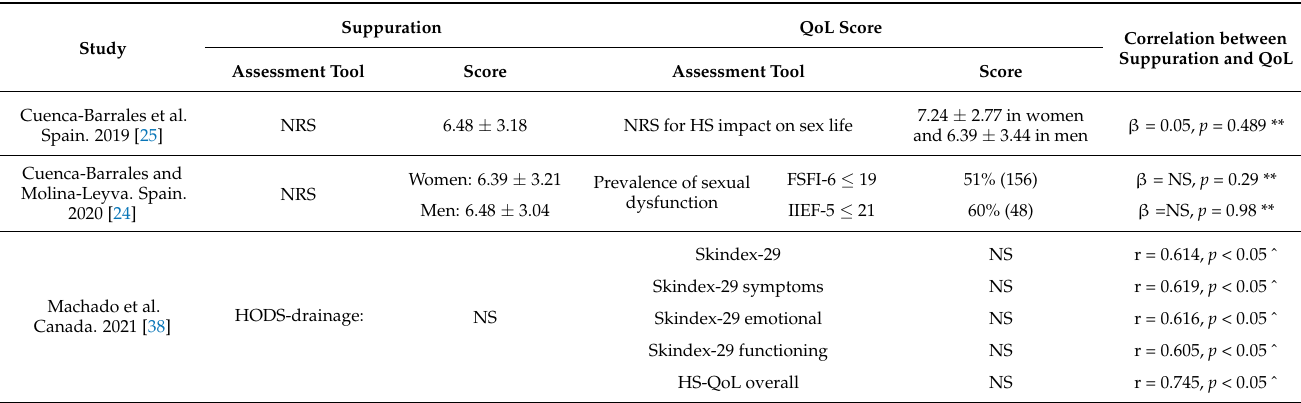
Table 5. Studies regarding suppuration impact on